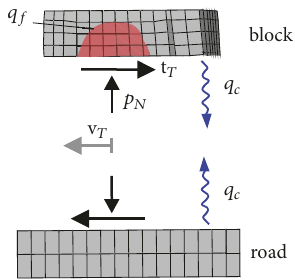
Figure 11: Rubber block-road contact